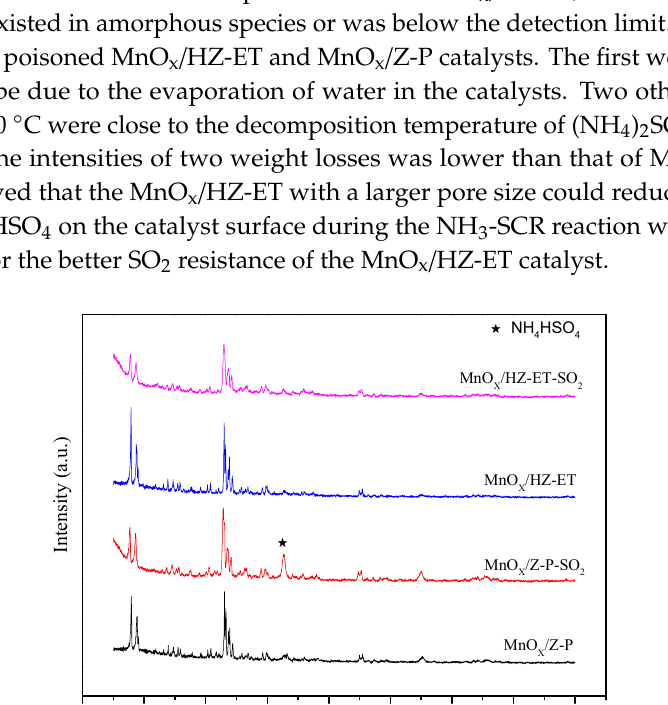
Figure 9. XRD patterns of the catalysts used.